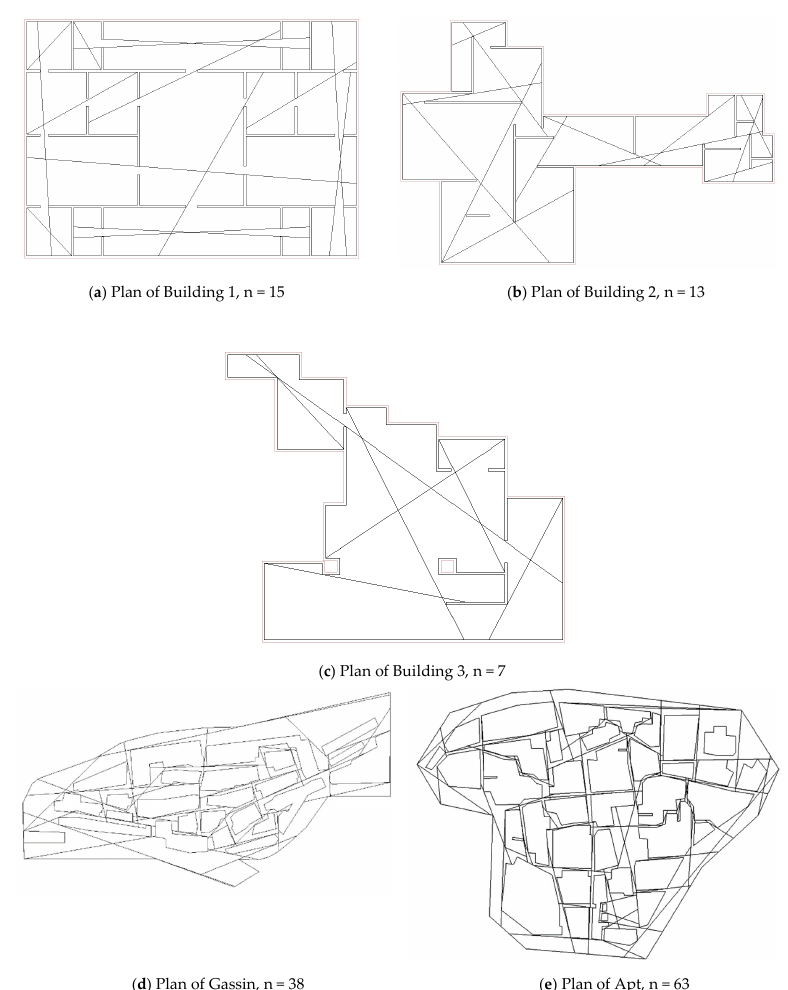
Figure 6. Minimal sets and numbers of axial lines in building and urban layouts. ( a ) Plan of Building 1, n = 15 ( b ) Plan of Building 2, n = 13 ( c ) Plan of Building 3, n = 7 ( d ) Plan of Gassin, n = 38 ( e ) Plan of Apt, n = 63.